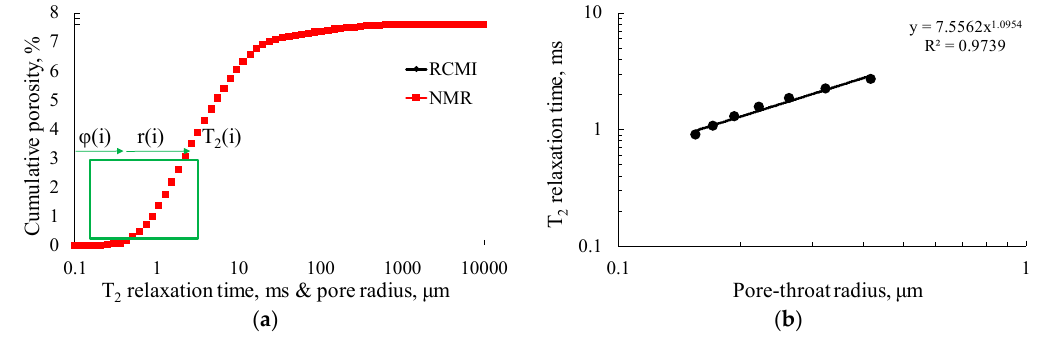
Figure 11. Methods for determining the improved-NMR PSD by the integration of NMR and RCMI, taking B116 specimen in the research area as an example: ( a ) data selection; ( b ) relationship between T 2 relaxation time and pore-throat radius.